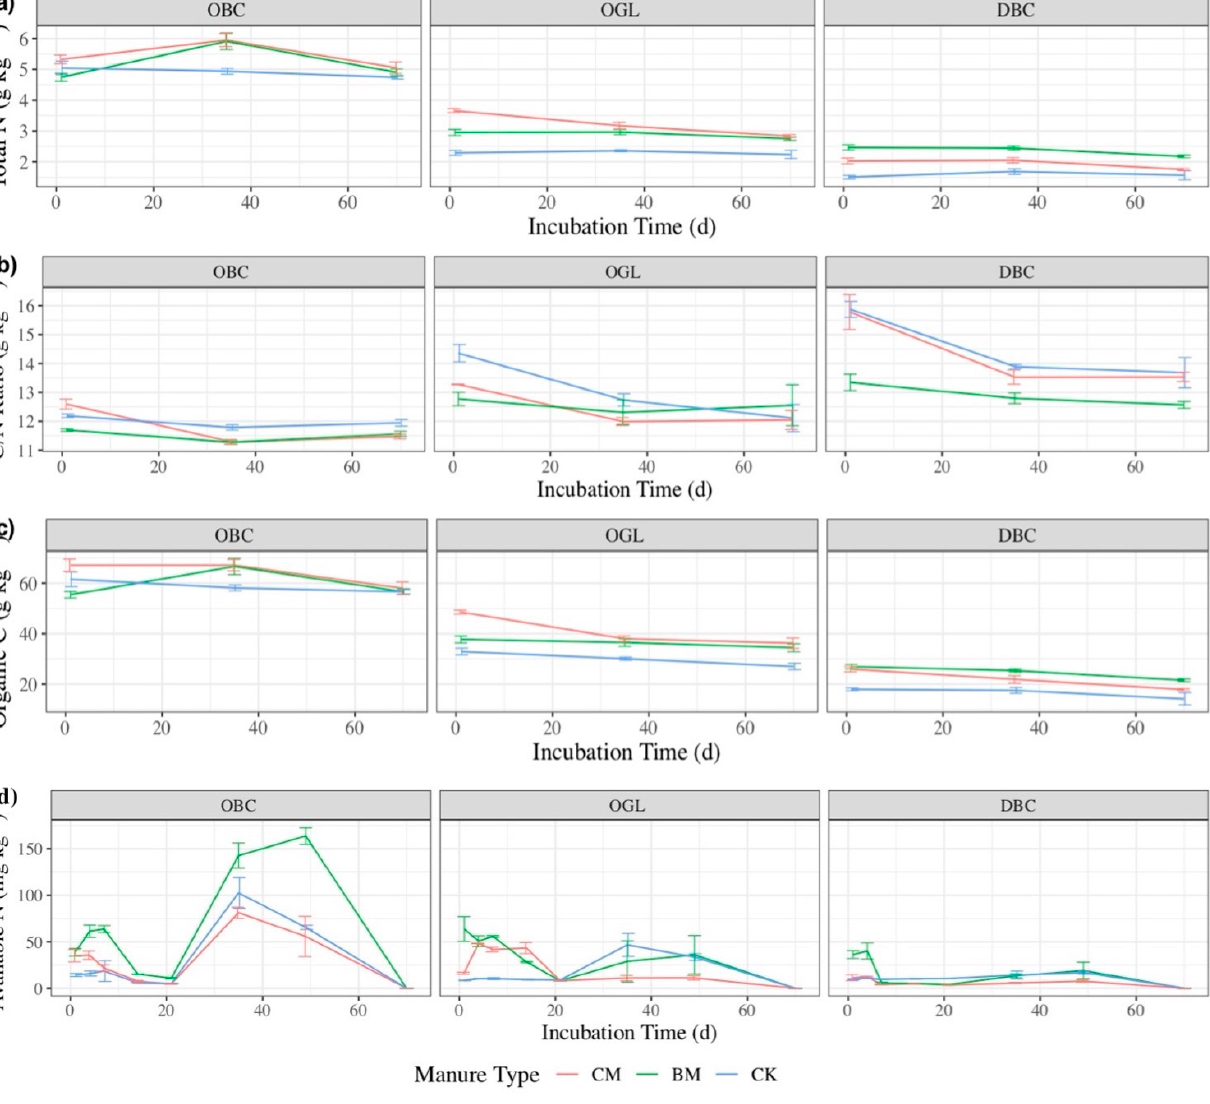
Figure 2. Effects of manure type on ( a ) total nitrogen (N), ( b ) carbon (C) to N ratio, ( c ) organic C, and ( d ) available N across three soil types throughout the incubation. Soil type: OBC, Orthic Black Chernozem; OGL, Orthic Gray Luvisol; and DBC, Dark Brown Chernozem. Manure type: CM, manure from cattle fed a corn silage-based backgrounding diet; BM, manure from cattle fed a barley silage-based backgrounding diet; and CK, control (soil without amendments). Vertical bars indicate standard errors of the means ( n = 4).